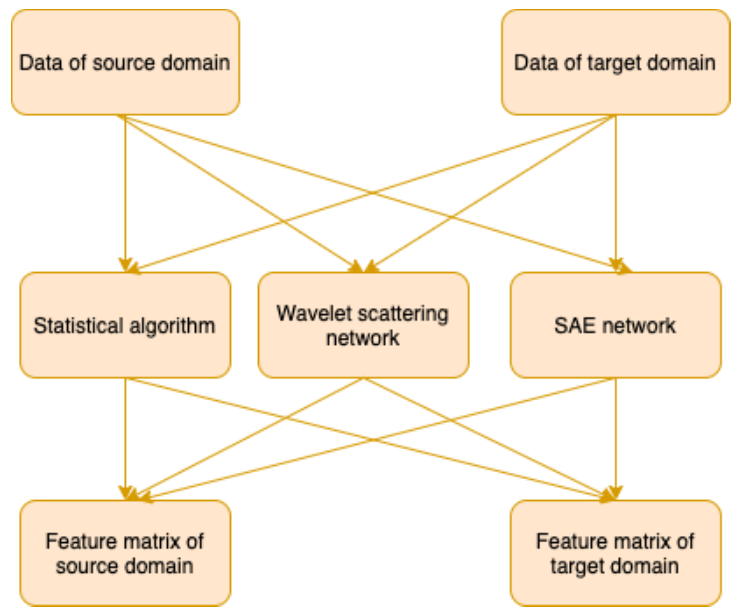
Figure 3. The structure of feature